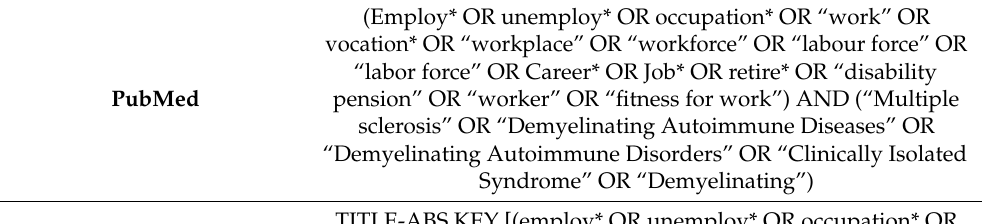
Syndrome” OR “Demyelinating”)